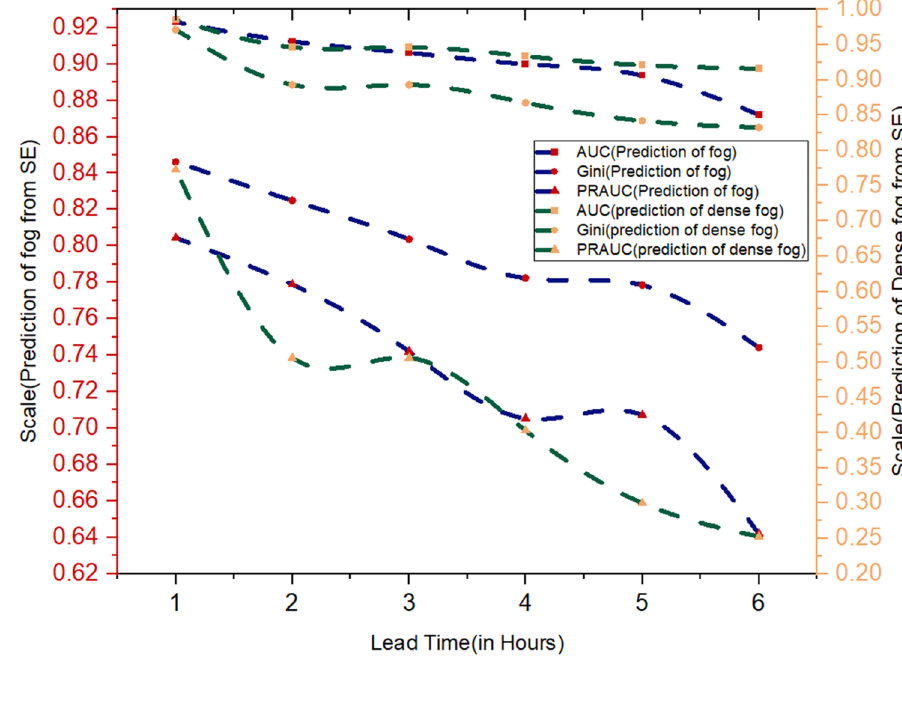
Fig. 8 The Statistical skill score of the proposed machine learning algorithms for the prediction of Fog (Surface Vis- ibility ≤ 1000 m) and dense fog ((Surface Visibility ≤ 200 m)